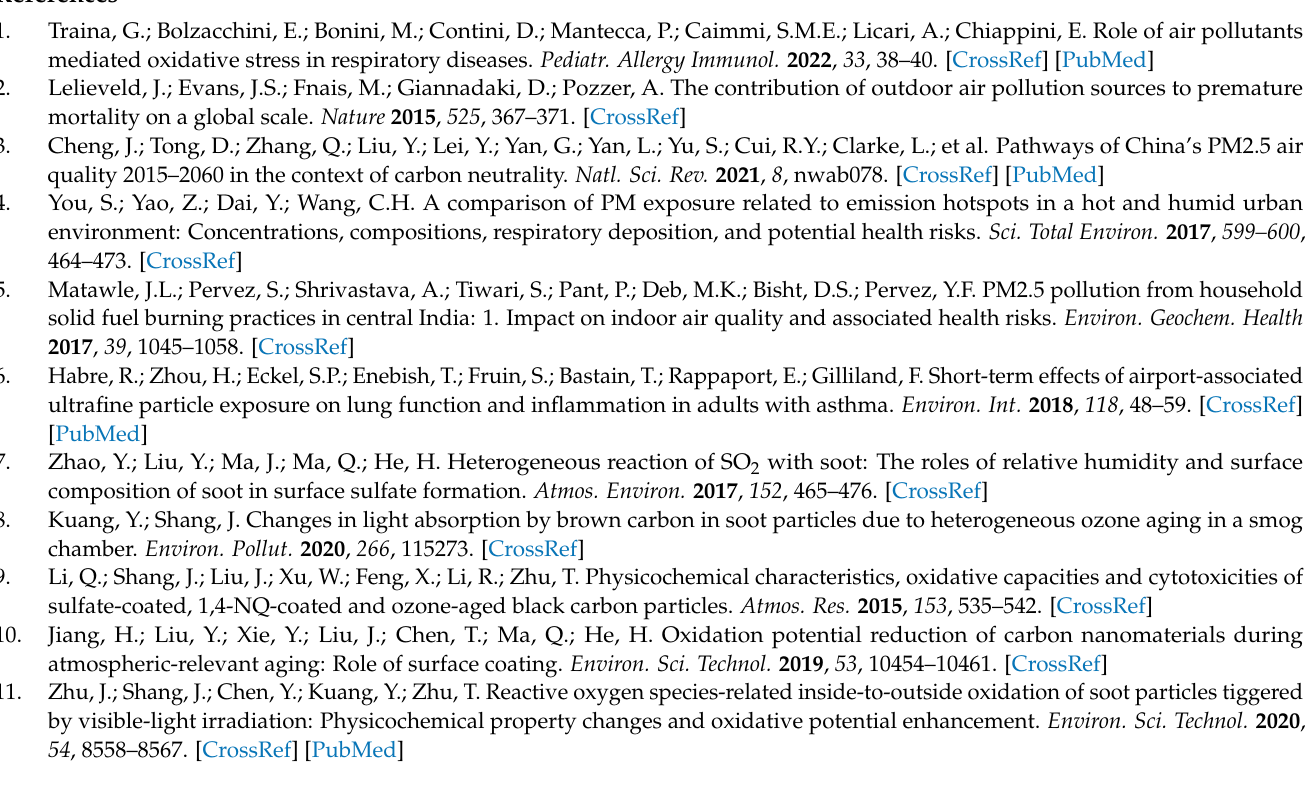
Table S1: The primers used in real-time quantitative reverse transcription-polymerase chain reaction (qRT-PCR) reactions in the current